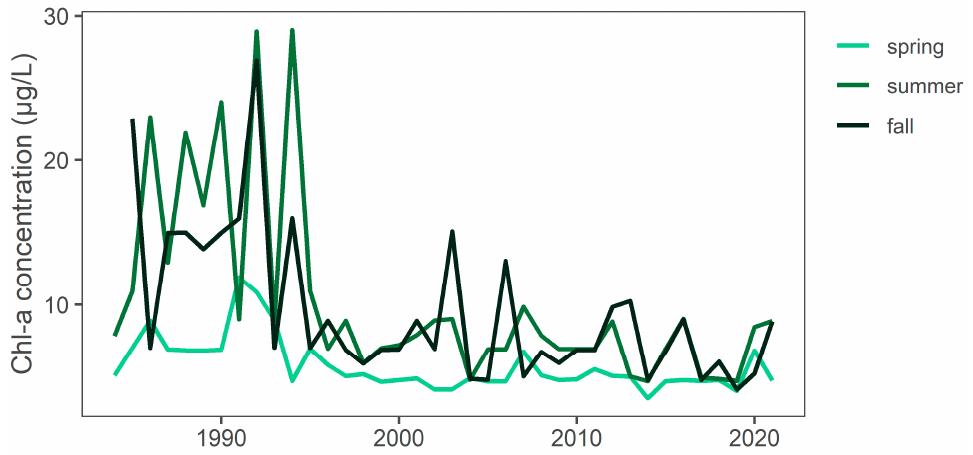
Figure 16. Time series of median values for the whole lake by season.